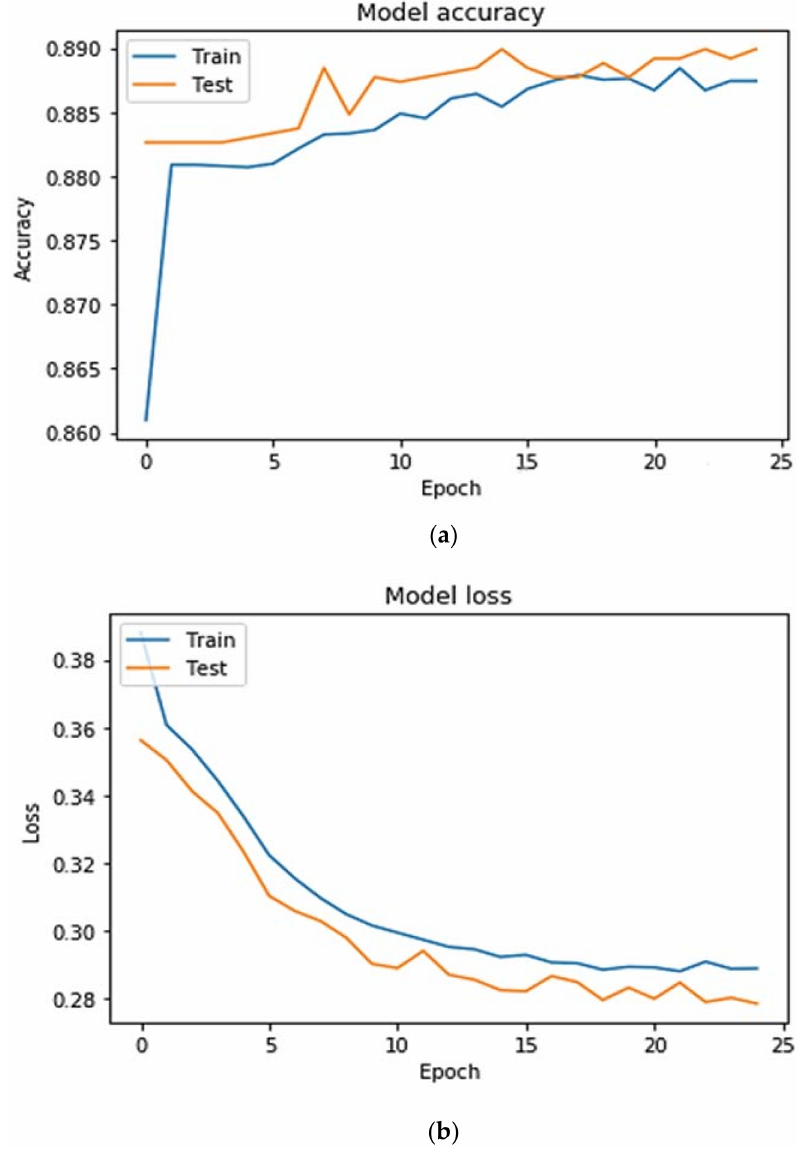
Figure 2. ( a ) CNN training accuracy graph and ( b ) CNN training loss